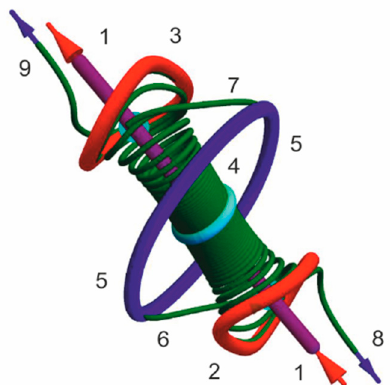
Figure 13. Energy flows for the “precesson”. The only vortex line 1 is oriented according to red arrows ( m = 1). It includes three special points where tangential component of energy flow changes sign. Around the special points there are closed lines of energy flow 2, 3, 4 (2 and 3 are unstable and 4 is saddle limit cycles). Vortex tube is a boundary surface of domain of attraction of energy flow lines in neighborhood of vortex lines 1. It is formed by separatrix energy flow lines beginning on unstable limit cycles 2 or 3 and ending on stable limit cycle 5 (like trajectories 6 and 7) or going to the periphery (like 8 and 9).